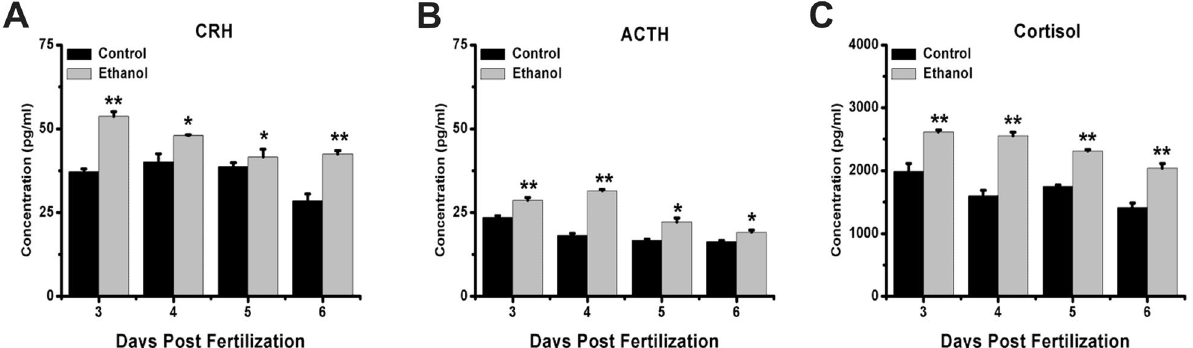
Figure 2. Effects of ethanol on HPA axis hormone levels in zebrafish larvae. Samples were taken at 3, 4, 5, and 6 dpf. (A) CRH levels from 3 to 6 dpf. (B) ACTH levels from 3 to 6 dpf. (C) Cortisol levels from 3 to 6 dpf. Three independent experiments were conducted. Student’s t-test was performed. *p < 0.05; **p < 0.01; ***p < 0.001.